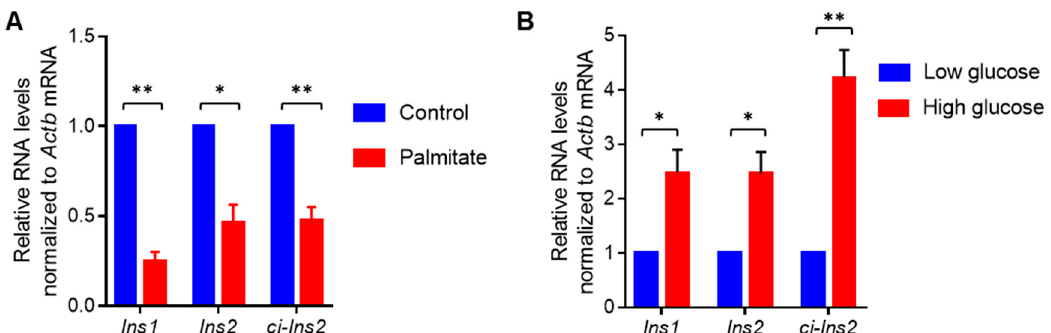
Figure 5. Altered expression of ci-Ins2 in β TC6 cells exposed to palmitate or high glucose. ( A ) RT-qPCR analysis of Ins1 , Ins2 and ci-Ins2 in β TC6 cells cultured for 3 days in DMEM (25 mM glucose) + 1% fetal bovine serum (FBS) with or without 0.5mM sodium palmitate. ( B ) RT-qPCR analysis of Ins1, Ins2 and ci-Ins2 in β TC6 cells cultured for 7 days in low glucose (2.5 mM) or high glucose (25 mM) containing DMEM supplemented with 15% FBS. All results represent means ± SEM from 4 independent experiments. * p < 0.05, ** p < 0.001.